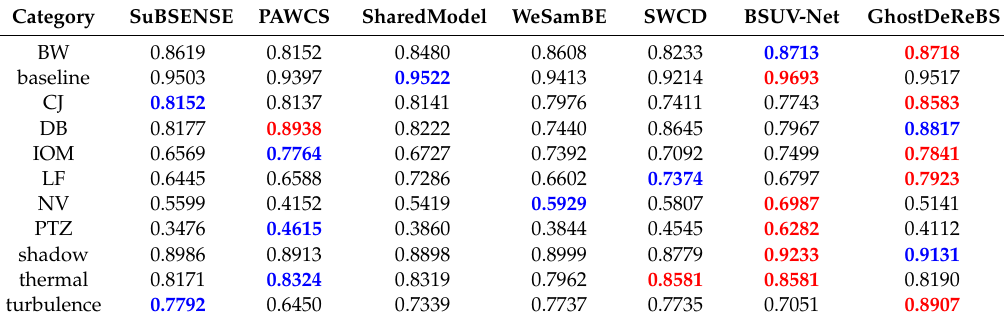
Table 8. F-measure comparison of each category on the CDnet 2014